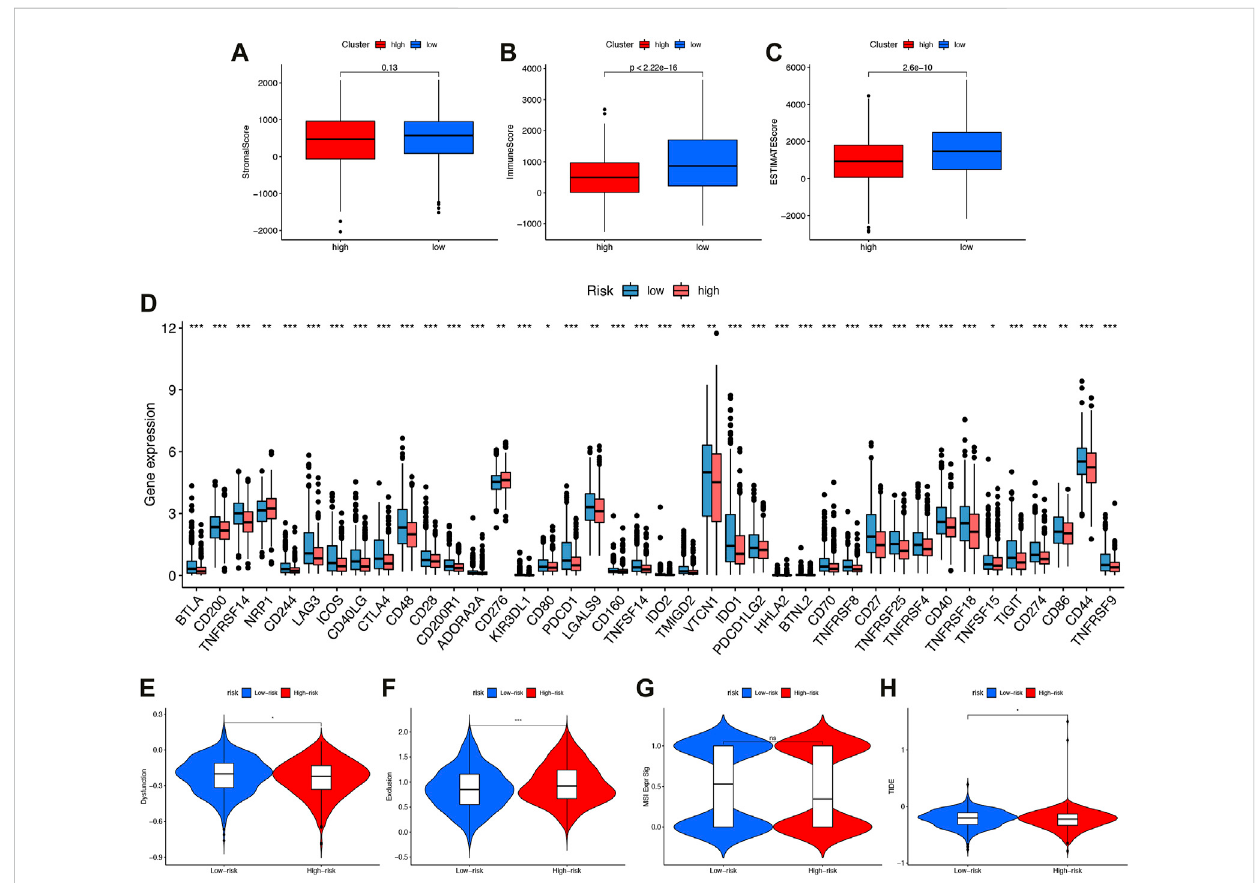
FIGURE 7 The immune microenvironment, immune checkpoints, immune escape (A – C) Comparison of interstitial scores, immune scores, and ESTIMATE scoresin high-riskand low-risk subgroups. (D) Boxplotshowed association between IFRSigand immune checkpoints.* p < 0.05, ** p < 0.01, *** p < 0.001. (E – H) Immune escape. (E) Dysfunction (F) Exclusion (G) MSIExprsig (H) TIDE score in different